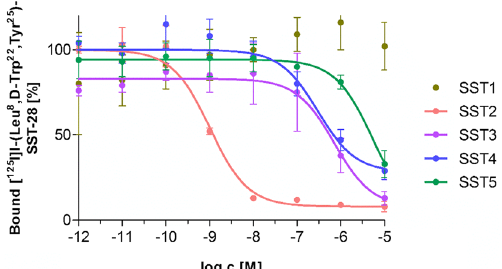
Fig. 2 Competition experiments using [ 125 I]I-(Leu 8 , d -Trp 22 , Tyr 25 )-somatostatin 28 as radioligand with increasing concentrations of SiTATE on human sst1-5 membrane